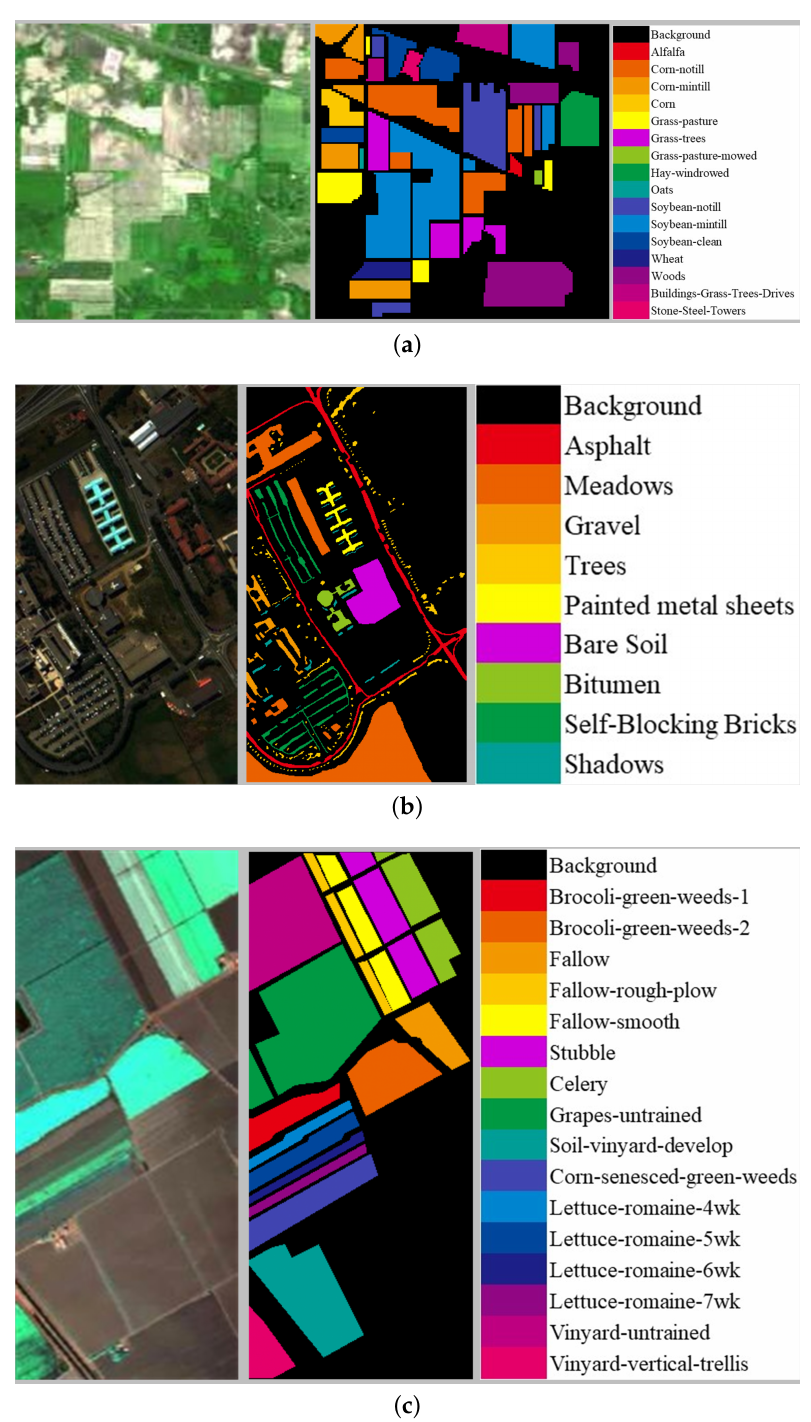
Figure 5. ( a – c ) The false-color image and ground-truth map of the IP, UP, and SV datasets.